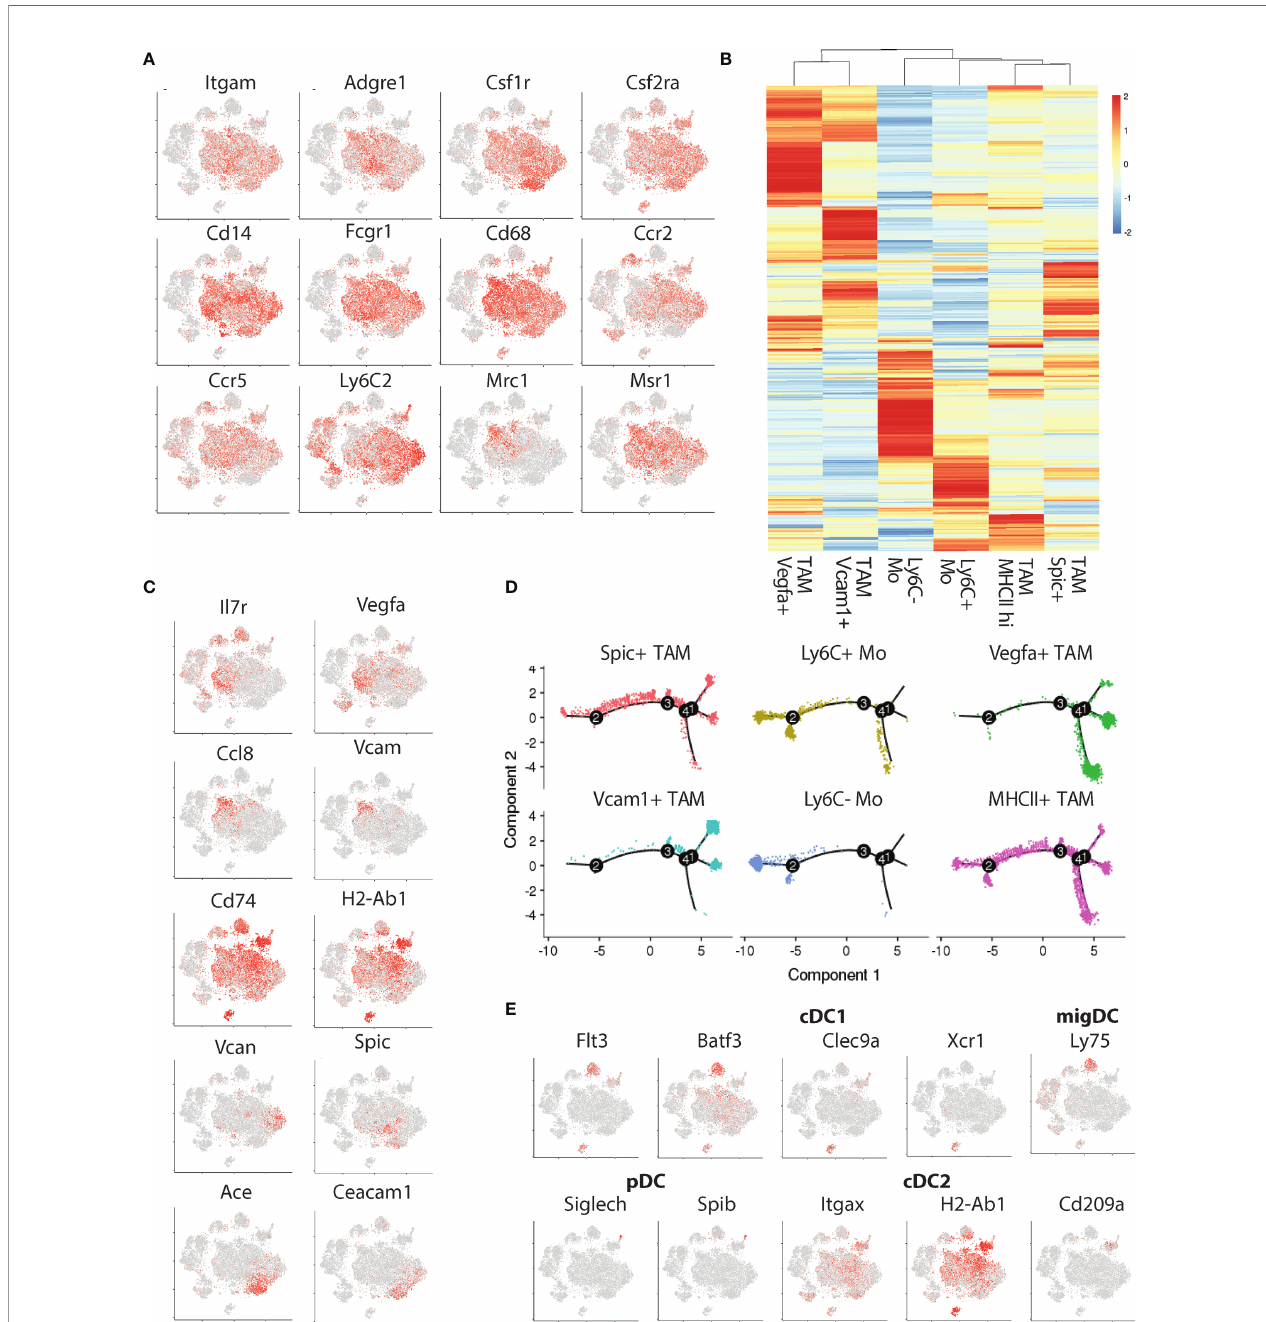
FIGURE 2 | Transcriptional phenotyping of tumor-associated macrophage populations. (A) The expression of canonical macrophage lineage markers denotes a large cluster of TAMs comprising the bulk of the CD45 + in fi ltrate, (B) Hierarchical clustering of TAM subset marker genes identi fi ed during Seurat subset clustering, (C) Expression distribution of TAM-subset speci fi c marker genes, (D) Pseudotime plot showing relative distances of TAMs to one another, split by cluster, denoting transcriptional relationships between TAM subsets, and, (E) tSNE plot showing marker distribution of key cDC-subset associated